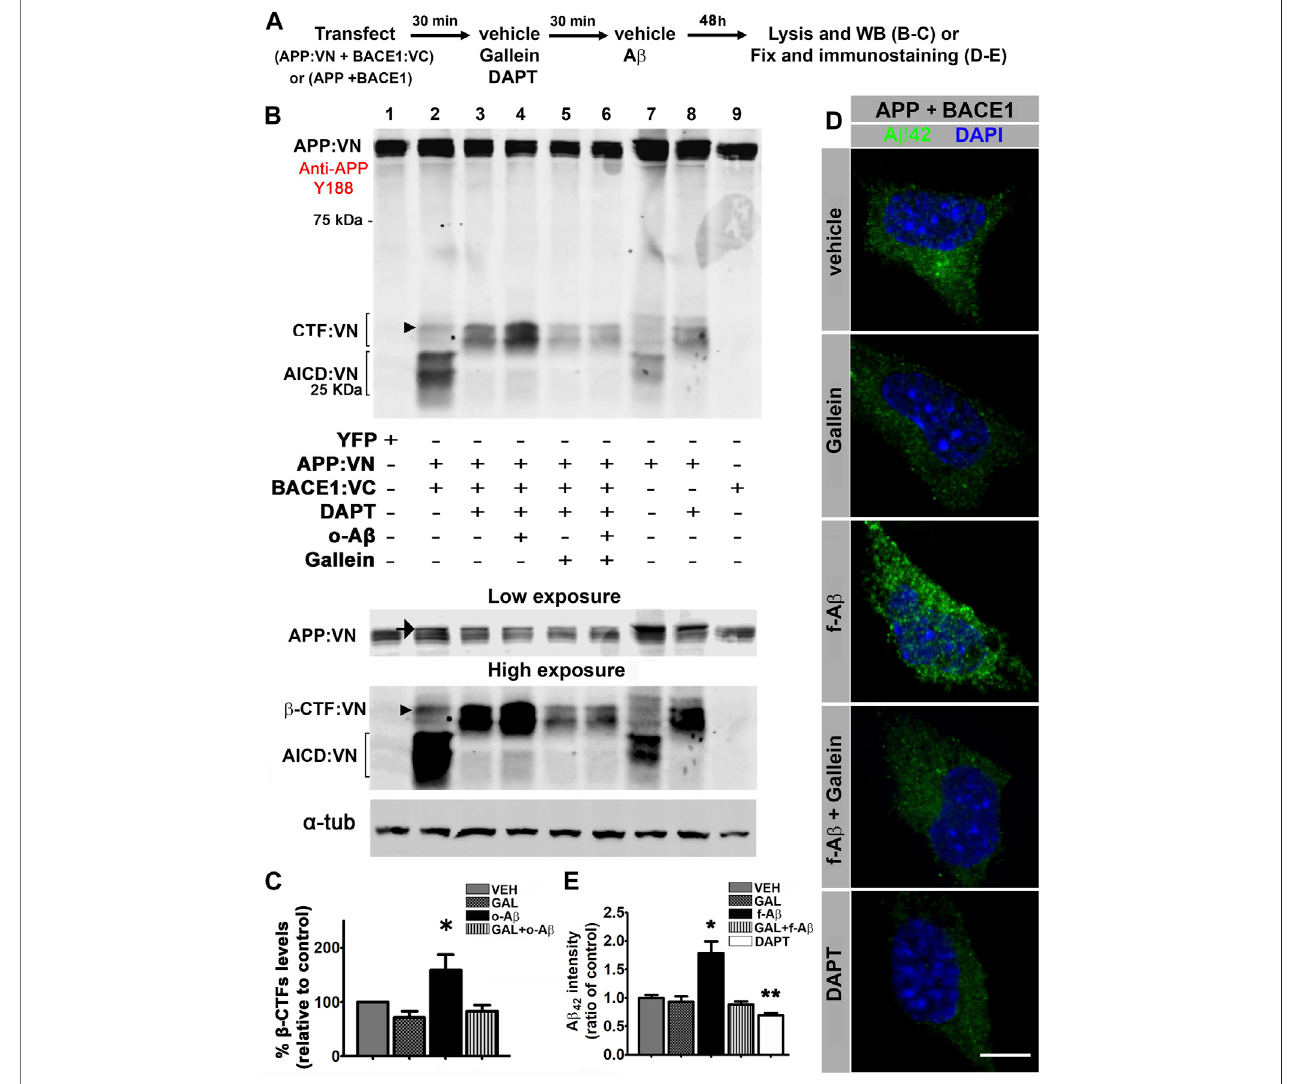
FIGURE 3 | Fibrillar and oligomeric A β enhance amyloidogenic processing of APP and promote intracellular accumulation of A β 42 through a G βγ -dependent signaling in N2a cells. (A) . Experimental diagram for B-E. (B) . Cell lysates of N2a cells co-transfected with APP:VN and BACE1:VC and treated under the indicated conditionswereanalyzedbyWesternblotwithantibodyY188thatrecognizetheC-terminaldomainofAPP.BandscorrespondingtoCTF:VNandAICD:VNareindicated by brackets. Molecular weight markers are indicated in kDa. Low and high exposures of the same blot are shown below to allow a better visualization of bands corresponding to APP: VN (low exposure) and β -CTF:VN (high exposure), which enabled their better identi fi cation for quanti fi cation. Arrow in the low-exposure panel points to full-length APP:VN. Arrowheads point to β -CTF:VN. Loading control α -tubulin is shown in the bottom. (C) . Quantitative densitometry analysis of β -CTF:VN bandsafternormalizationoftheirlevelstothoseofcorrespondingloadingcontrolband(n=4)*: p < 0.05vs.allotherconditionsbyANOVAfollowedFisherLSD post-hoc test. Inallcasesvaluesdenotemean±SEM. (D) .ConfocalimagesofN2acellsco-transfectedwithwild-typeAPPandBACE1plasmids,inmunolabeledwithantibodyto A β 42 and treated under the indicated conditions. (E) . A β 42 fl uorescence intensity expressed as ratio of control (n = 55; 10 – 12 cells for each condition) *: p ≤ 0.05. In all cases, data represent mean ± SEM. Scale bar is 10 μ